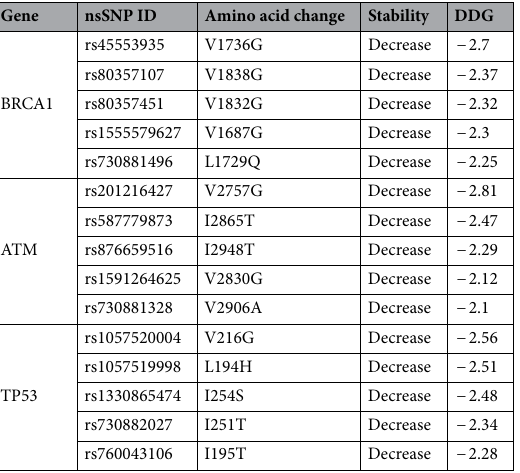
Gene SNP ID miR ID miRSite Target sites disrupted by SNPs and INDELs in miRNA seeds ATM Target sites created by SNPs and INDELs in miRNA